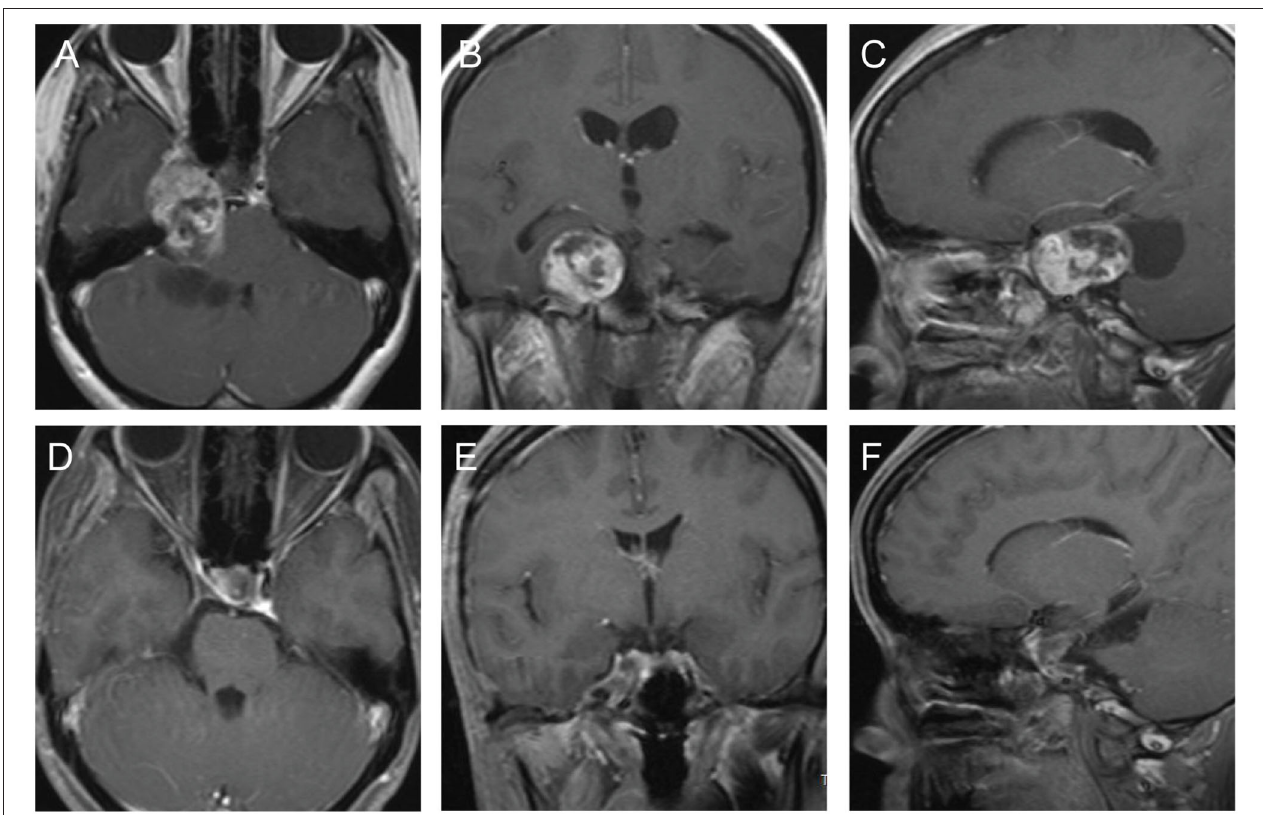
FIGURE 4 | The preoperative and postoperative MRI imaging of case 4. (A–C) Preoperative MRI showed a dumbbell-shaped tumor involving both the right middle and posterior fossae. (D–F) Postoperative MRI showed the most of the tumor was completely